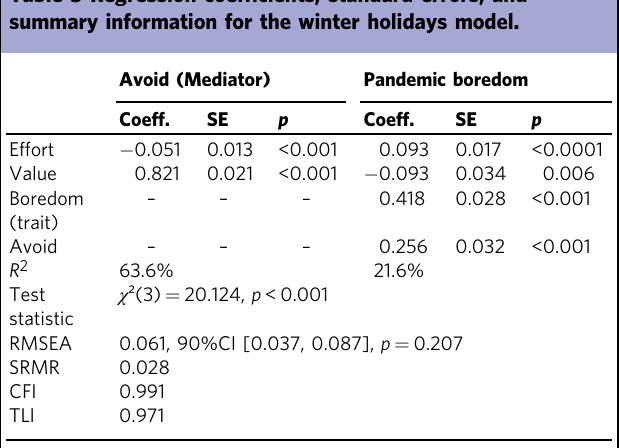
Table 5 Regression coef fi cients, standard errors, and summary information for the winter holidays model.